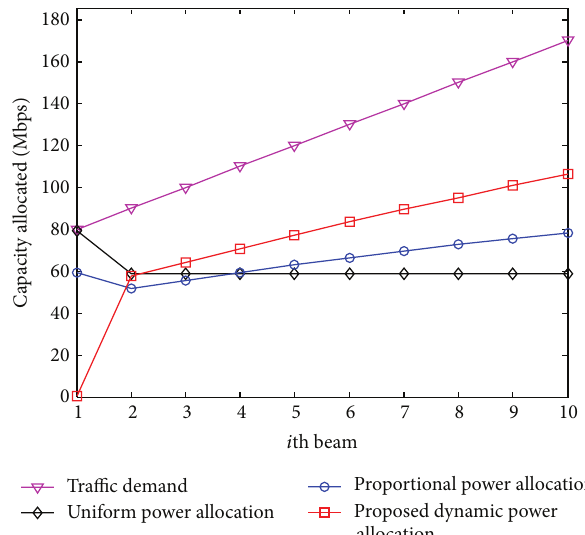
Figure 4: Distribution of the allocated capacity to each beam, for the three algorithms in Scenario 2.